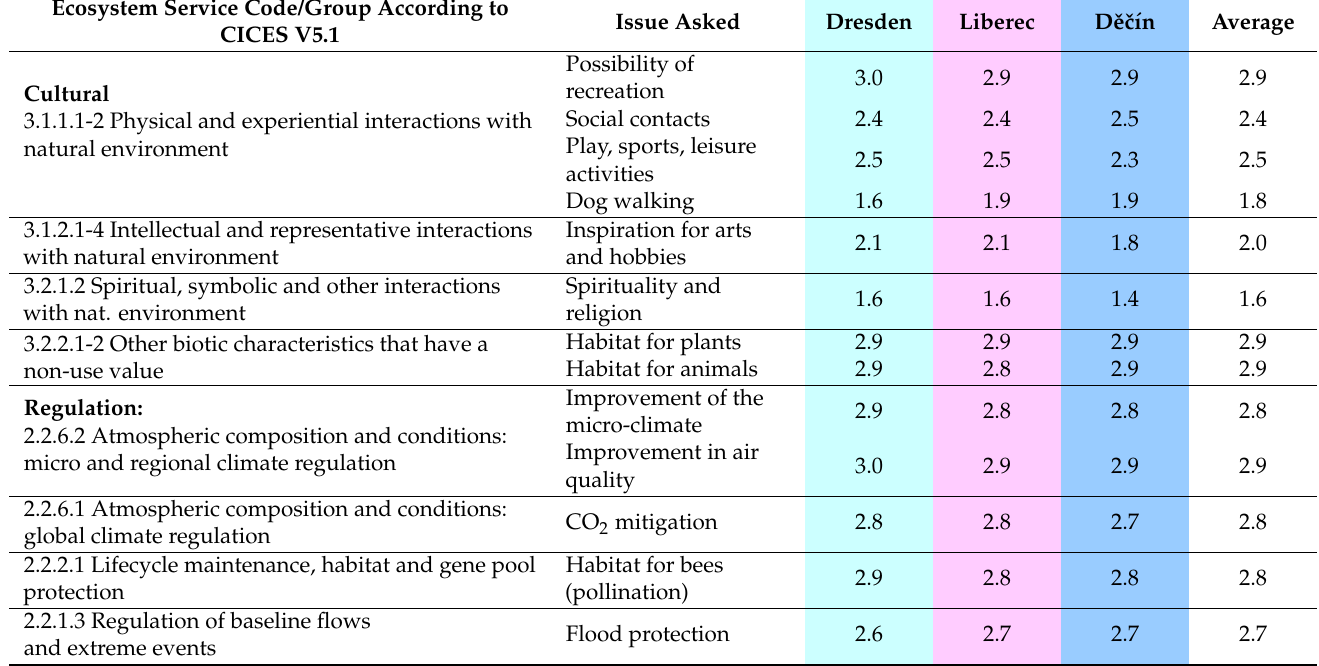
Table 8. Appreciation of selected urban ecosystem services (from 3: highly important to 1: unimportant). Ecosystem Service Code/Group According